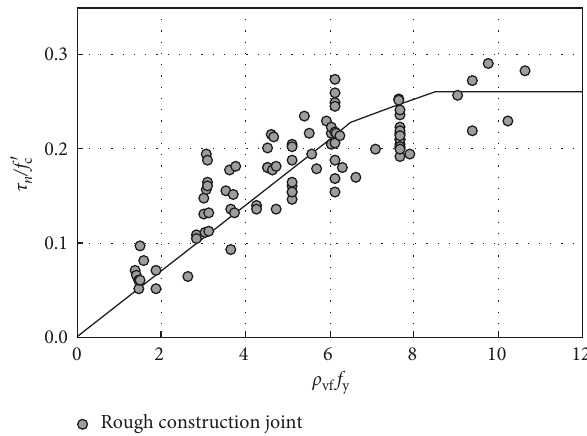
Figure 4: Relationship between τ struction joints.